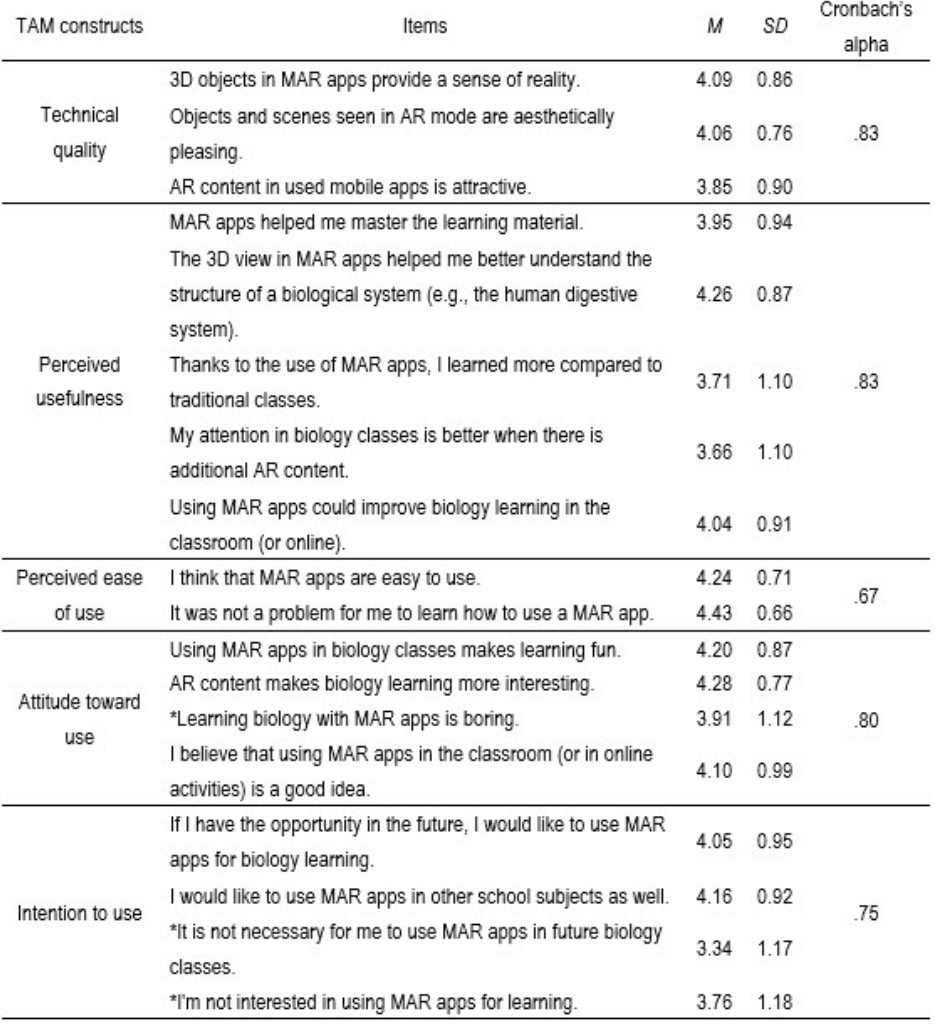
Cronbach’s alpha values for TAM constructs and means and standard deviations of